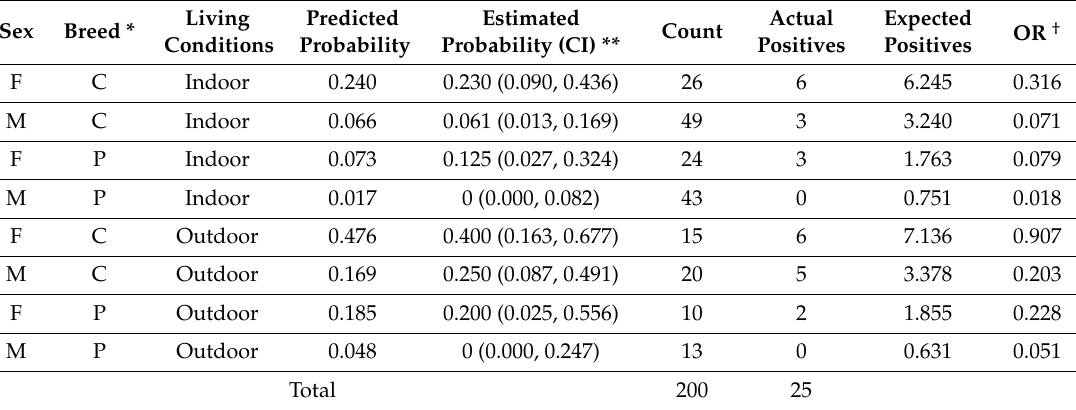
Table 4. Height factor combinations and corresponding odds ratio (OR) and probabilities (normalized to interval 0–1) predicted with the logistic